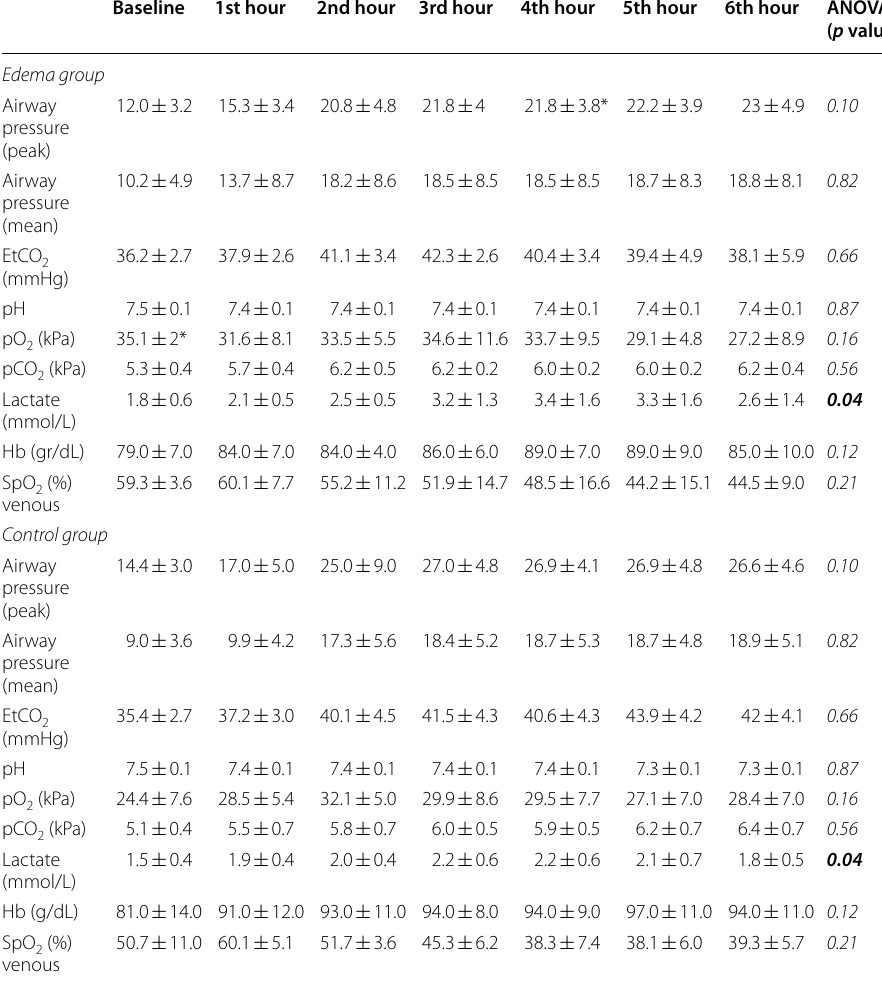
Table 2 Respiratory and blood gas analysis